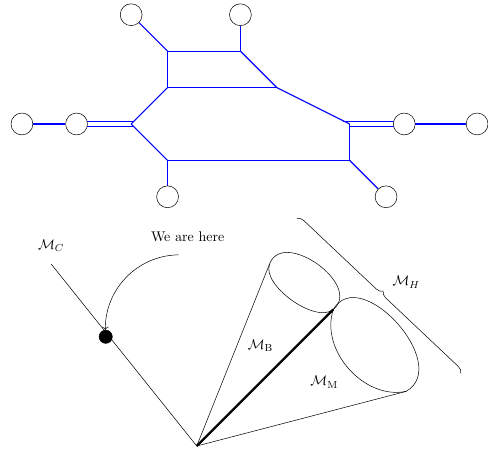
(a) The baryonic branch is indicated in the brane web. Coloured branes are assumed to be on different ( x 7 , x 8 , x 9 ) positions in space.